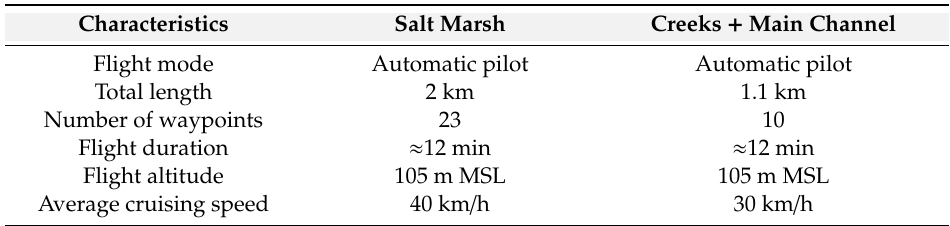
Table 3. Flight details for the second UAV, which collected RGB images over marshes, creeks, and main